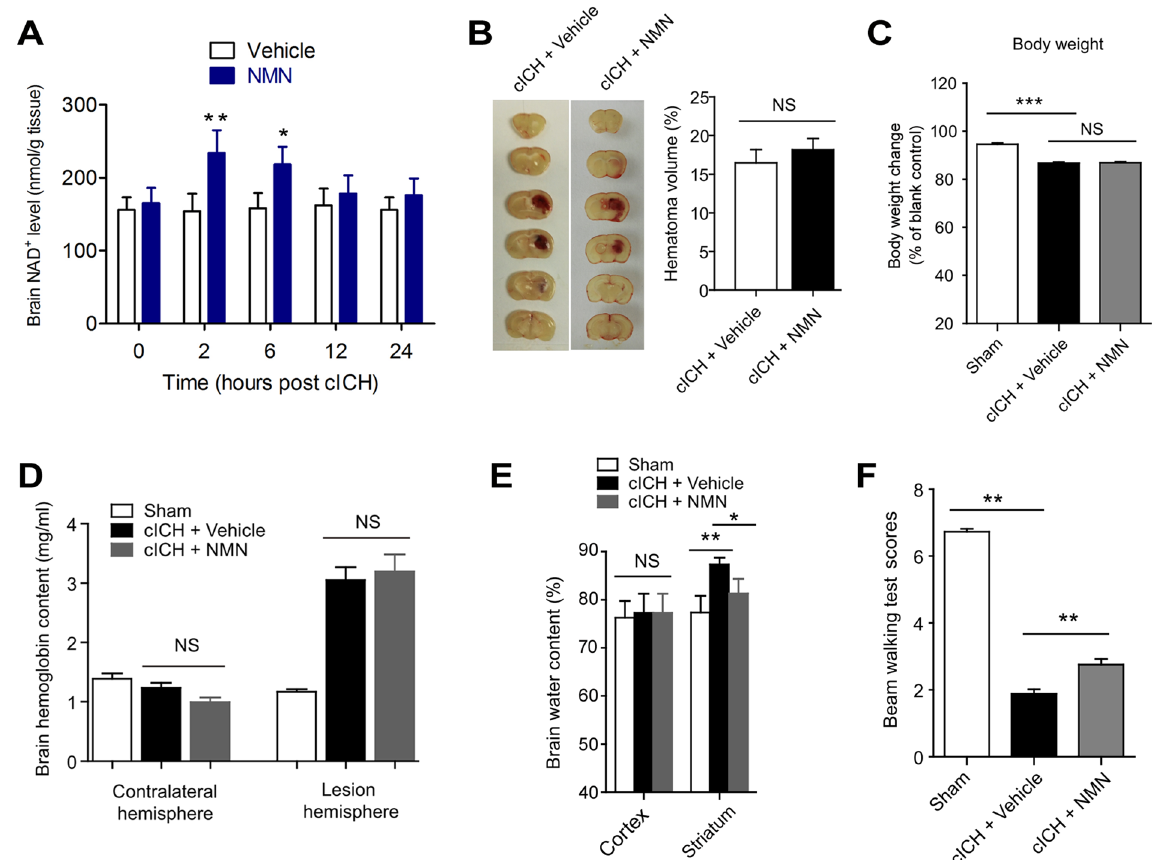
Figure 1. Nicotinamide mononucleotide (NMN) treatment protects against cICH-induced brain injury. ( A ) NAD + level in brain tissue was measured at 2 hours after injection of NMN from tail vein. * P < 0.05 vs Vehicle; NS, no significance. N = 6 per group. ( B ) Brain hematoma volume at 24 hours after cICH. n = 8 per group. ( C) Body weight at 24 hours after cICH. *** P < 0.001 vs Sham, n = 22, 60 and 63 in Sham, cICH + Vehicle and cICH + NMN groups respectively. ( D ) Hemoglobin content at 24 hours after cICH. n = 8 per group. ( E) Brain water content at 24 hours after cICH in cortex and striatum. ** P < 0.01 cICH + Vehicle vs Sham, * P < 0.05 cICH + NMN vs cICH + Vehicle, n = 8. ( F ) Neurological deficit was evaluated by beam walking test at 24 hours after cICH. ** P < 0.01, n = 26, 69 and 73 in Sham, cICH + Vehicle and cICH + NMN groups respectively. NS, no